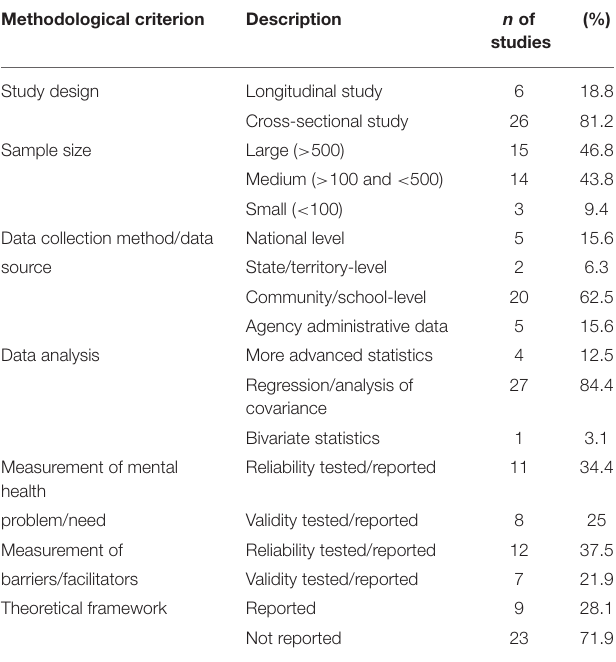
TABLE 1 | Methodological characteristics of the reviewed studies (N =